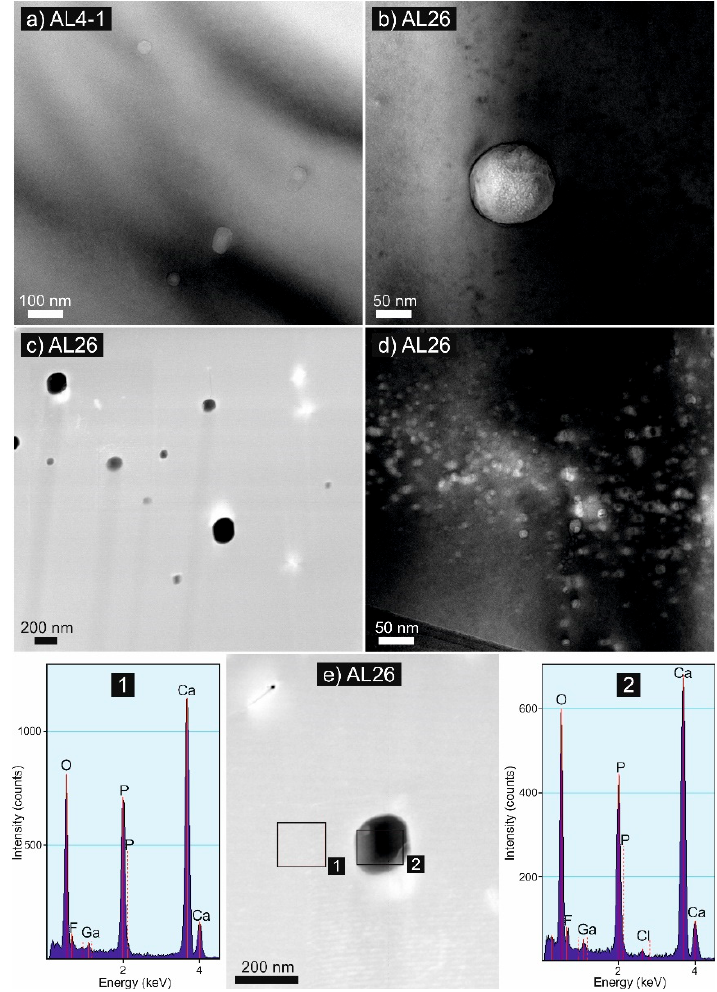
Figure 2. Bright-field images ( a,b,d ) and high-angle annular dark-field (HAADF) images ( c,e ) of spherical fluid inclusions in apatite crystals from BIF and metachert. EDX analyses indicate chlorine enrichment of such an inclusion (analysis No. 2) in Cl-poor apatite AL26 (analysis No. 1).